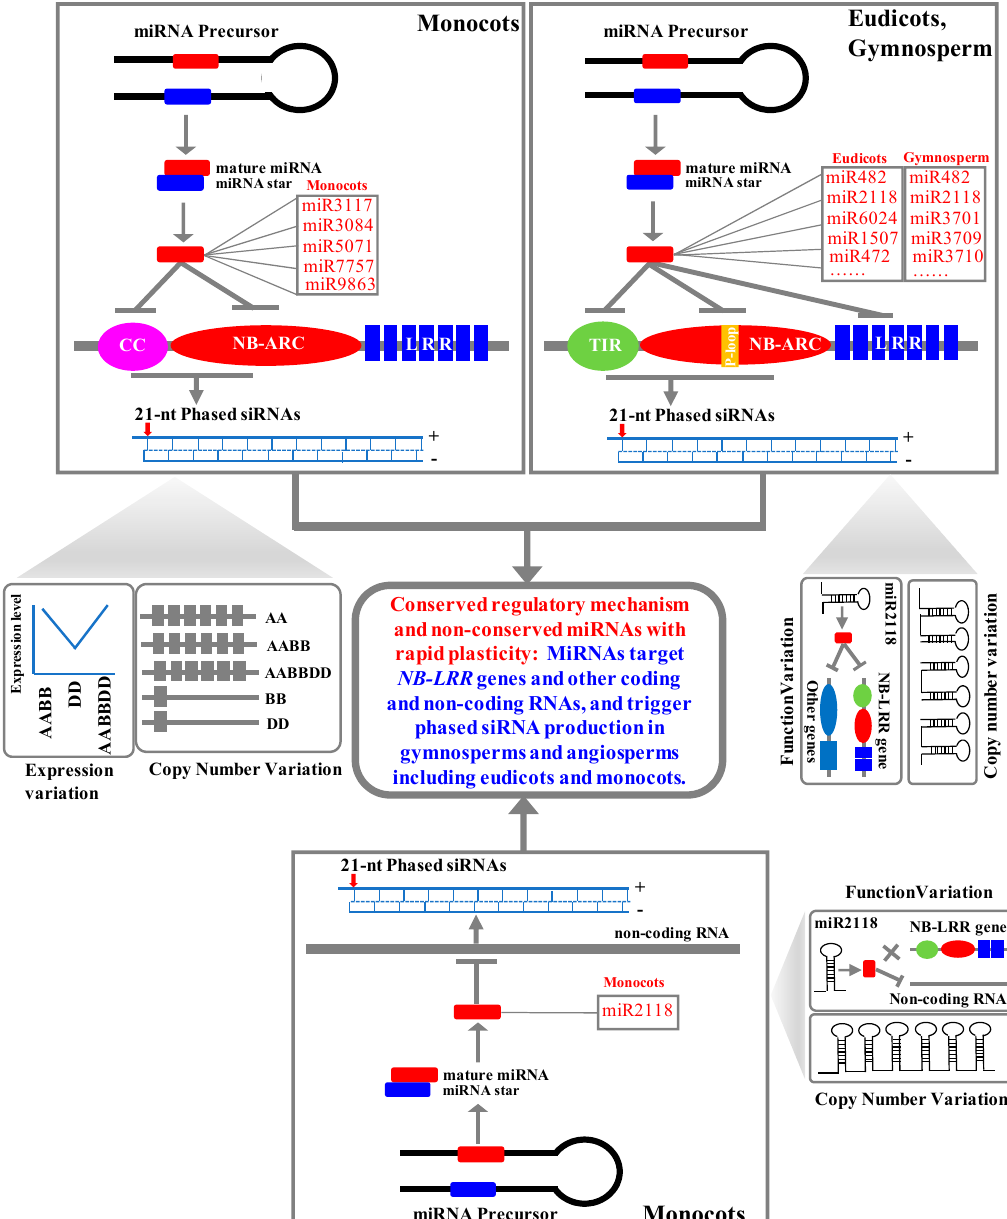
Figure 9. The conservation mechanism of miRNAs regulating the NB-LRR genes in plants in the top panel, their rapid plasticity including expression level in the left middle panel, their copy number in the right middle panel, and their function in the bottom panel.